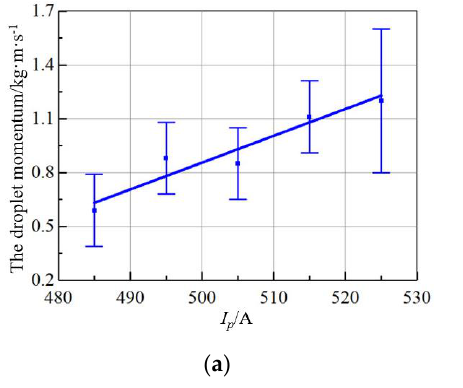
Figure 11. Effect of I p on droplet momentum, arc, and droplet impact pressure. ( a ) The droplet mo- mentum; ( b ) the pressure of the arc and droplet.